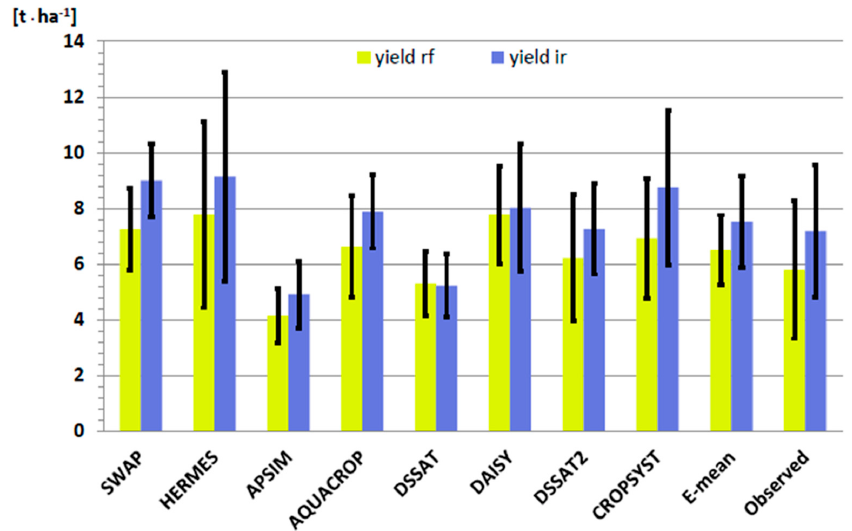
Figure 4. Simulated grain yields of winter wheat for rainfed (_rf) and irrigated (_ir) variants of the Müncheberg field trial from different models. Error bars of the model results and observations show inter ‐ annual variability, error bars of the ensemble mean the inter ‐ model variability. The simulated yields of the FACE experiments at Braunschweig are shown in Figure 5. As expected, all models simulated an increase of grain yields under the elevated CO 2 concentration.